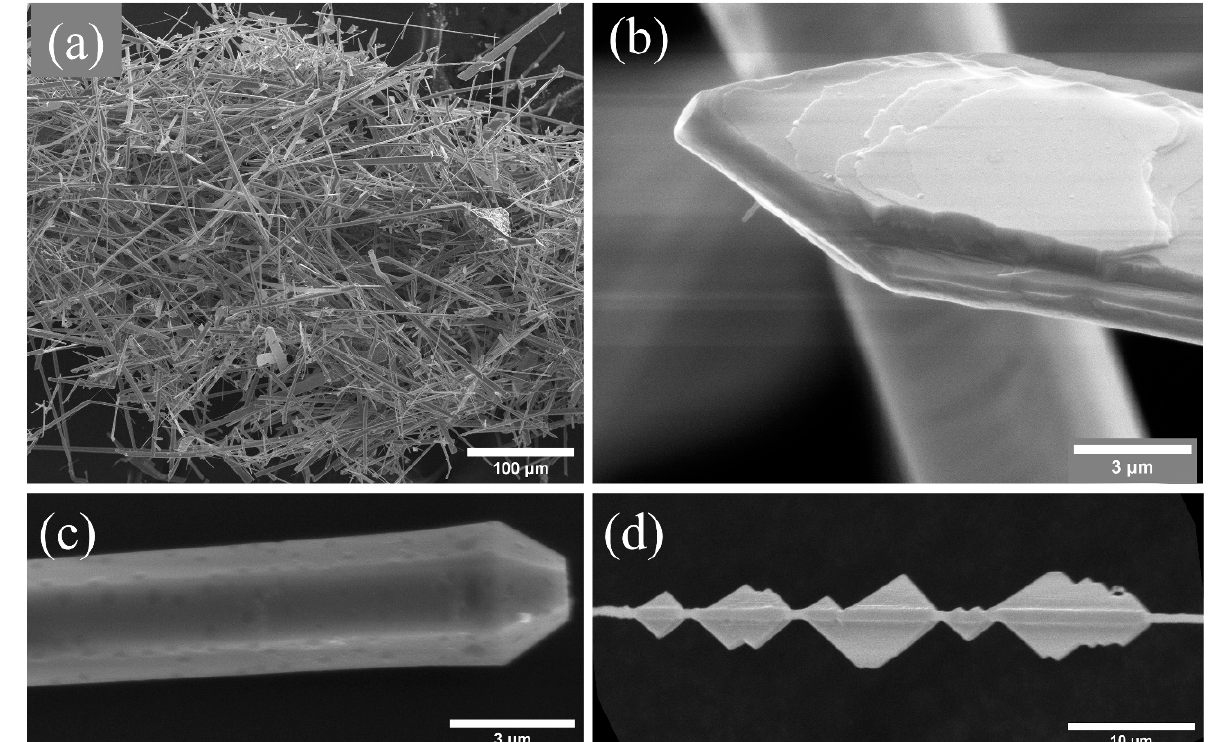
Figure 2. ( a ) General view of the morphologies of the structures grown, ( b ) detail of a ribbon with arrow ends, ( c ) needles with hexagonal cross-section and ( d ) central needle with triangle-shaped secondary growths.